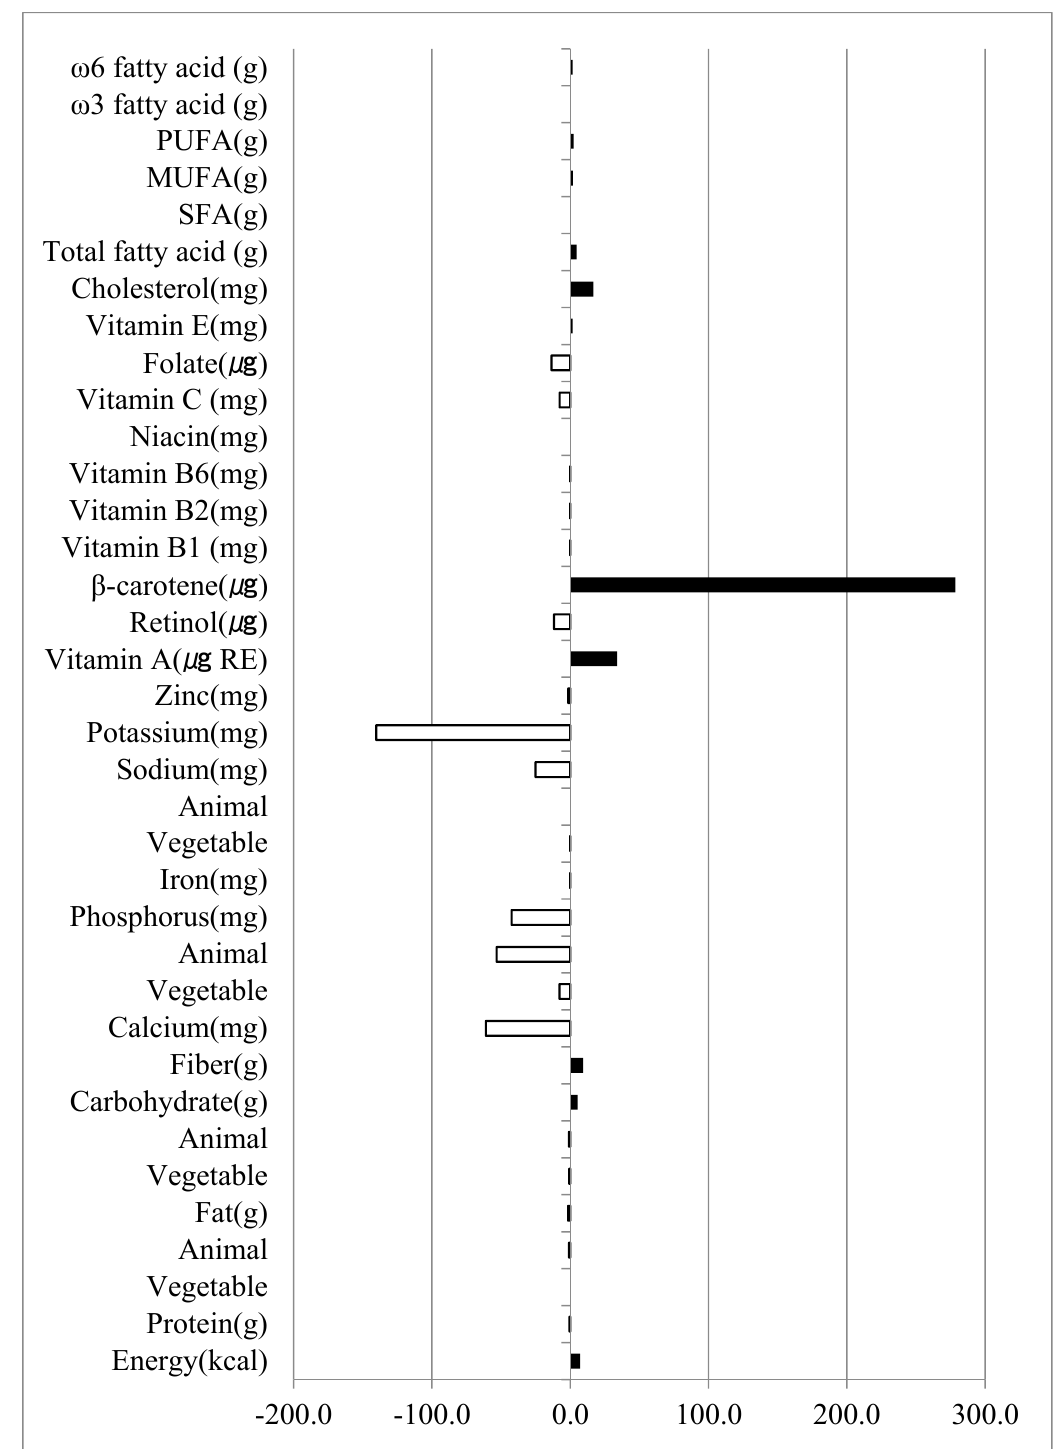
Figure 2. Nutrient intake differences based on the Phase 2 –Phase 1 intake values. Paired T-test crude model, genders not separated.